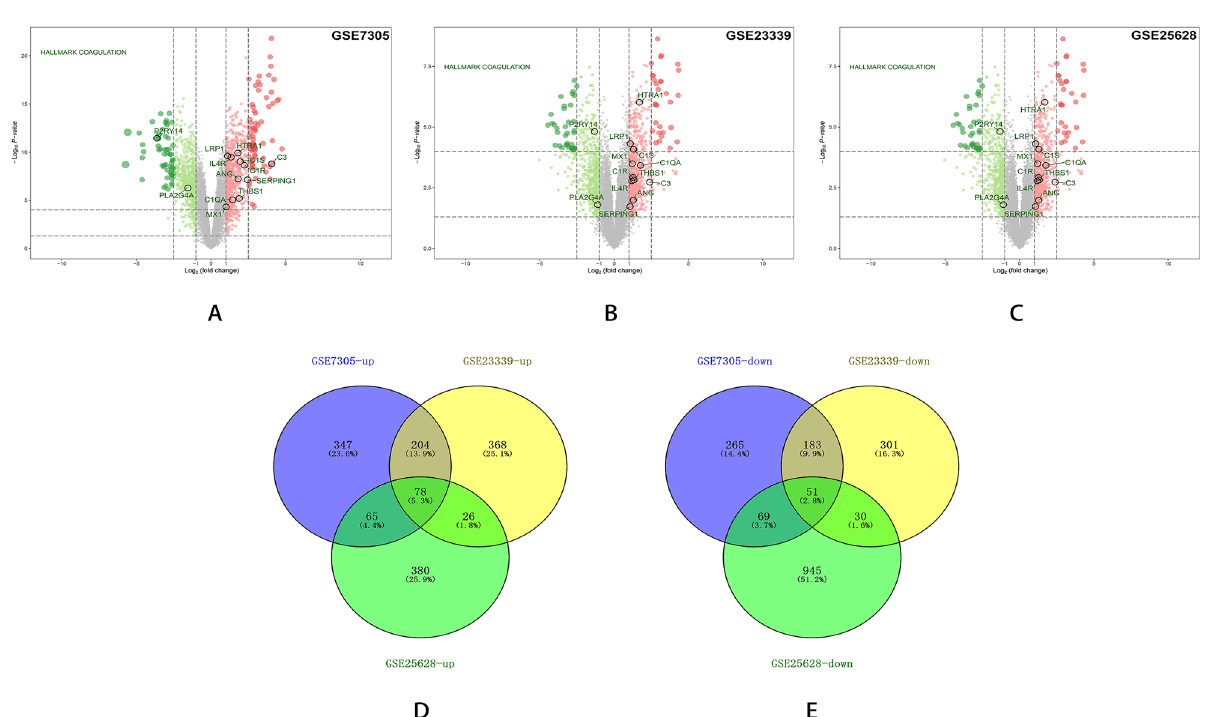
Figure 3. Volcano plots and Venn diagrams of DEGs in endometriosis microarray datasets. Volcano plots showing DEGs in GSE7305 ( A ), GSE23339 ( B ), and GSE25628 ( C ). DEGs are those genes with P-value < 0.05 and |log (FC)|> 1. Red indicates relative up-regulated genes and green indicates down-regulated genes. Venn diagrams of up-regulated ( D ) or down-regulated ( E ) DEGs from these three datasets, as